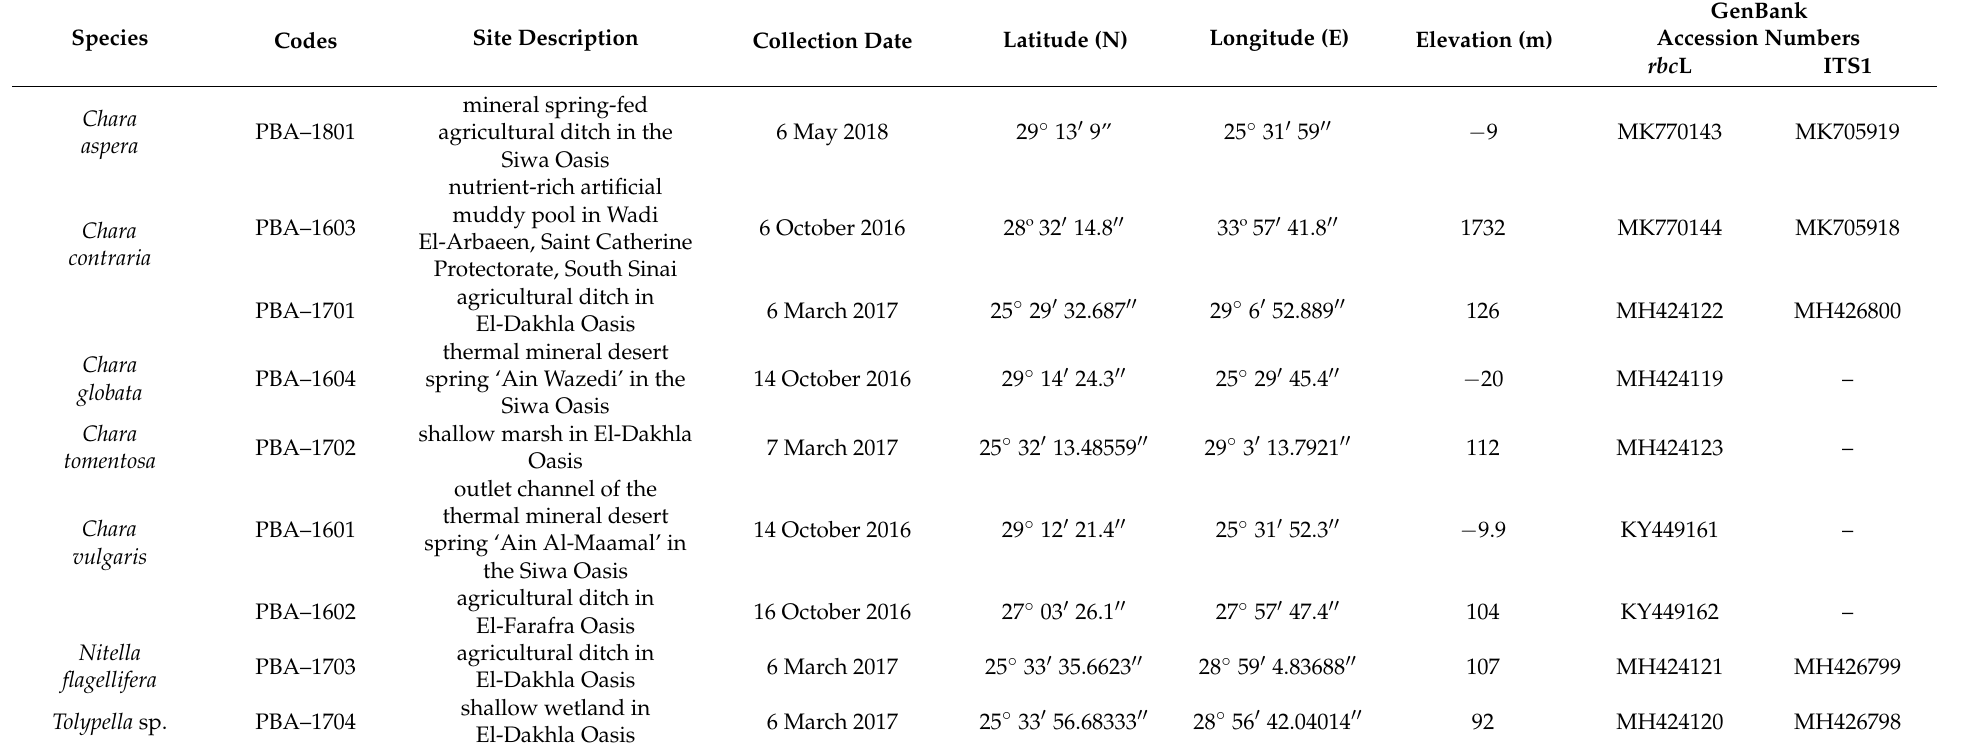
Table 2. Meta-data associated with each charophyte species investigated in our